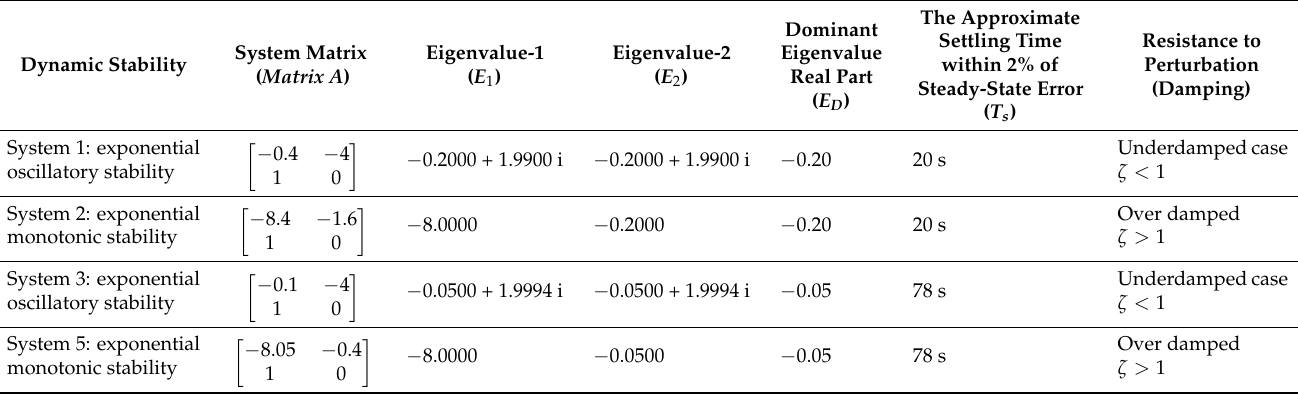
Figure 9. Lyapunov function (V) indicative of local asymptotic stability for the simple pendulum system (Case example 2) along with the system phase portraits under [ − 1.5 rad, 4] state initial values. As indicated in Table 5 and Figure 10, two identical systems might have different amounts of passive control (damping) but as long as their dominant eigenvalues’ real parts are equal, the resulting settling times will be equal irrespective of their behavior (monotonic or oscillatory). Table 5. System dominant eigenvalue’s real part as a direct indication of the system settling time (Case example